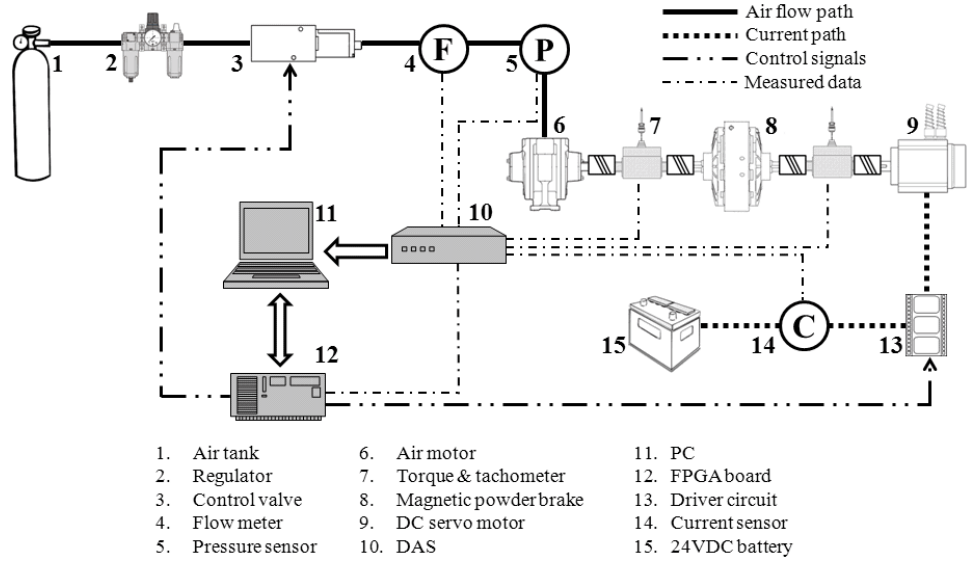
Figure 1. Control procedure of an air-electric power hybrid